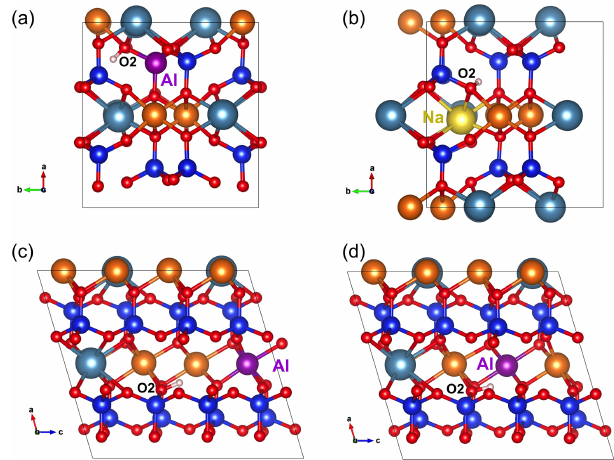
Figure 3. (a) Structure of (Al 3 + ,H + ) × defect in diopside viewed Si along the [001] direction (model 5, Table 1). (b) Structure of the (Na + ,H + ) × defect in diopside viewed along the [001] direction M2 (model 7, Table 1). (c) Structure of the [(1H + ) M2 (Al) M1 ] × _1 de- fect in diopside viewed along the [010] direction (model 8, Ta- ble 1). (d) Structure of the [(1H + ) M2 (Al) M1 ] × _2 defect in diopside viewed along the [010] direction (model 9, Table 1). Atom colors are the same as in Fig.